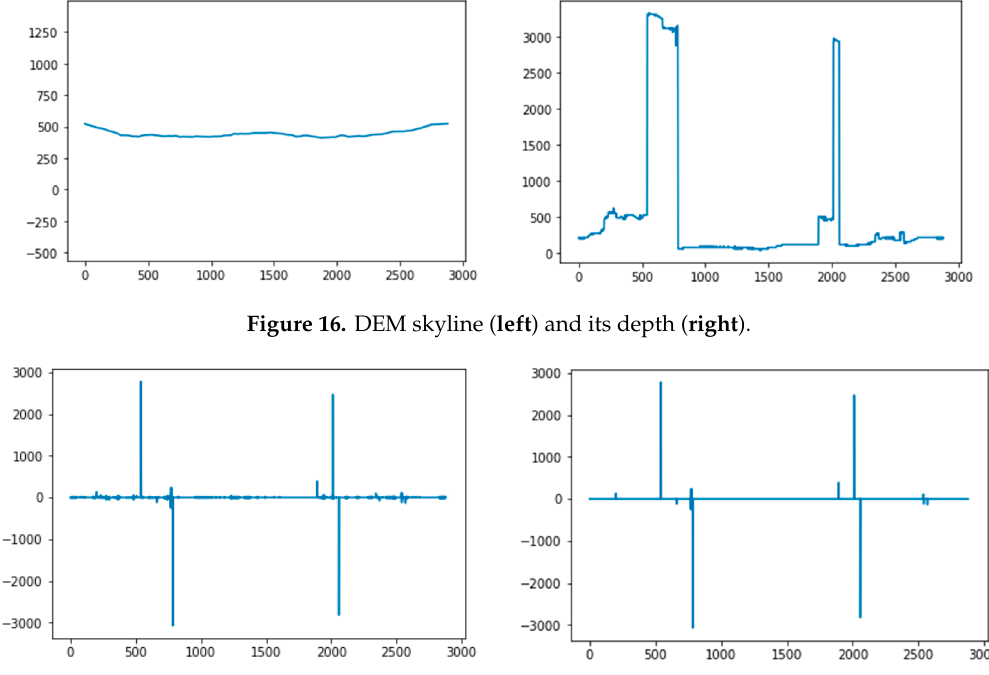
Figure 17. Example of first-order derivative of skyline depth ( left ) and the effect after thresholding ( right ).